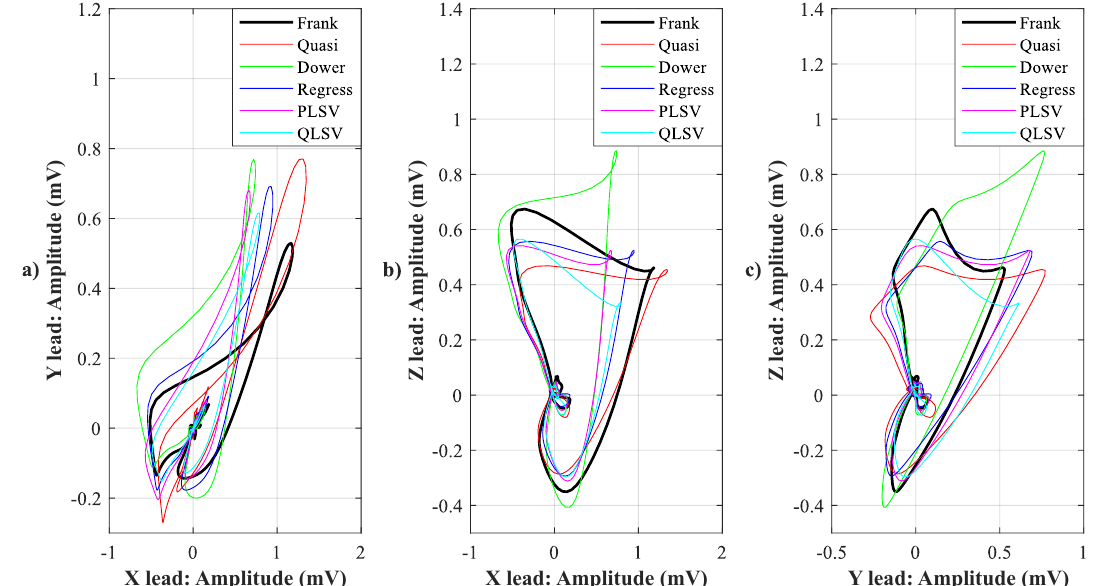
Figure 9. Comparison of transformation methods in 2-D, random patient 2. ( a ) X lead to Y lead, ( b ) X lead to Z lead, and ( c ) Y lead to Z lead.